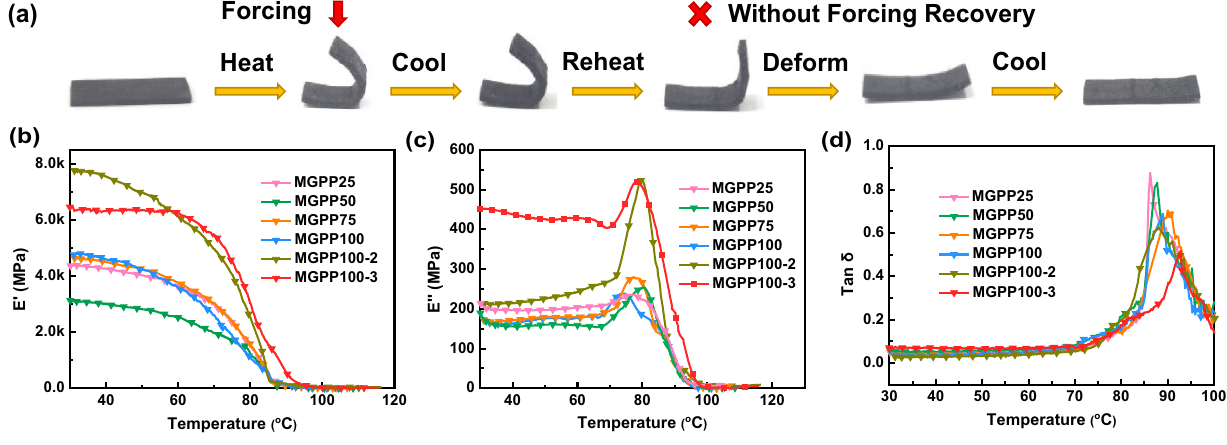
Fig. 6 a The digital images display the heat-sensitive shape memory feature of MGPP composite. b The storage modulus, c loss modulus, and d loss factor tan δ curves with